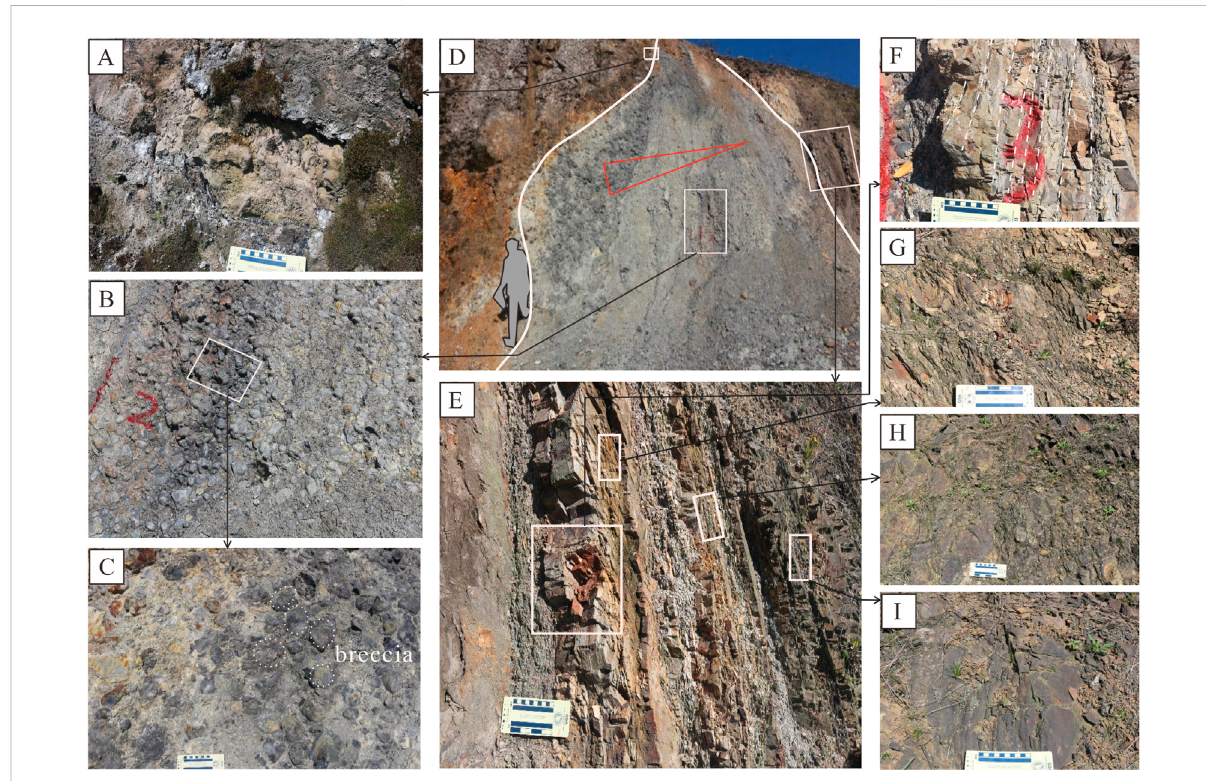
FIGURE 2 Typical lithological characteristics oflongtanformation. (A) :weathering crustontop ofMaokouFormation,withdarkened edgesofbaking; (B) : brown sedimentary volcanic breccia intercalated with tuff for Longtan Formation, seeing elliptic or round breccia; (C) : partial zoom-in of picture B, showingmostsiliceousbreccia,withtuffbetweenbreccia; (D) :fullviewoftheHongyanTownshippro fi le,showingthetopofMaokouFormationand the bottom of Longtan Formation, with breccia of Longtan Formation decreasing from the bottom up (in the red triangle); (E) : interbedding of brown sedimentary tuff and tuffaceous mudstone for Longtan Formation, with good strati fi cation; (F) : partial zoom-in of Picture E, showing thin, brown sedimentary tuff, with good strati fi cation; (G) : partial zoom-in of Picture E, showing very thin, brown tuffaceous mudstone, with good strati fi cation; (H) : partial zoom-in of Picture E, showing thin, brown sedimentary tuff; (I) : partial zoom-in of Picture E, showing the top brown tuffaceous mudstone, with good strati fi